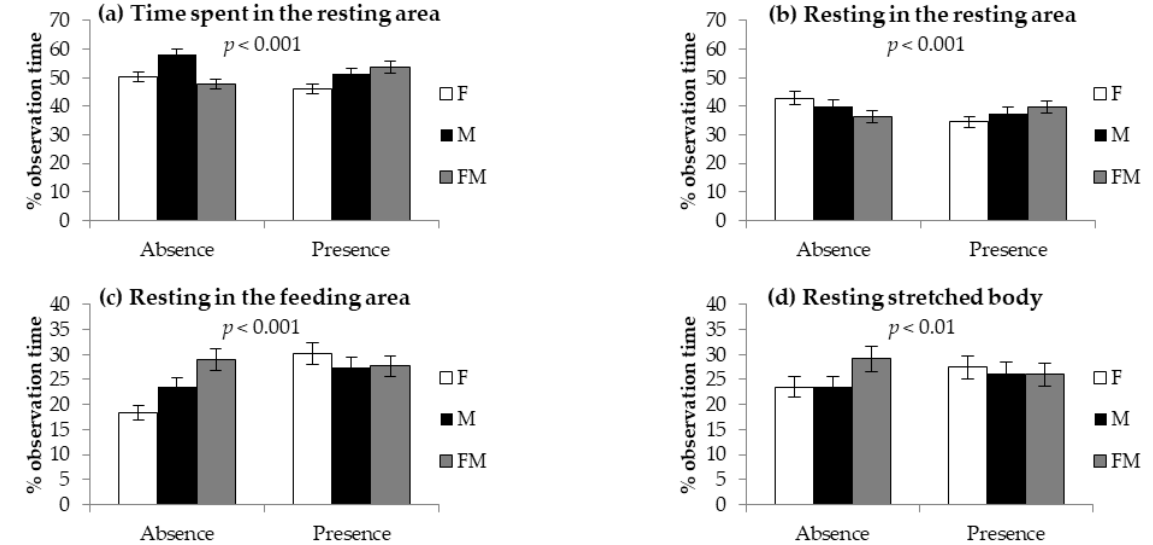
Figure 1. Time (% of observation time) spent ( a ) in the resting area, ( b ) resting in the resting area, ( c ) resting in the feeding area, and ( d ) resting with stretched body in growing rabbits kept in collective parks with only females (F), with only males (M), or with females and males (FM) in parks without (absence) or with (presence) gnawing hay blocks (significant interactions between group composition and presence/absence of gnawing blocks). Data are reported as the means ± standard deviations.